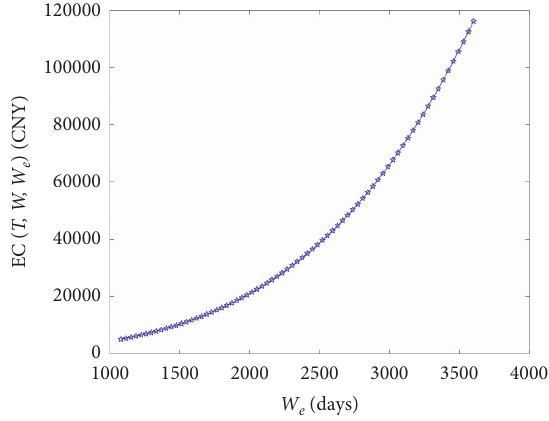
Figure 7: EW cost change only with minimal repair after failure. Table 3: Optimization plans corresponding to different EW periods.